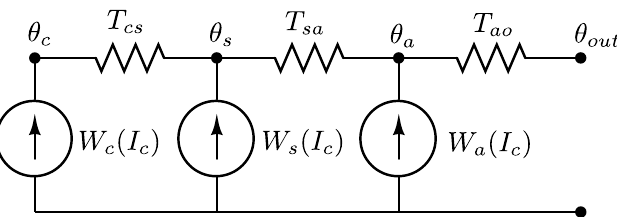
Figure 10. Equivalent electrical circuit for the heat transfer